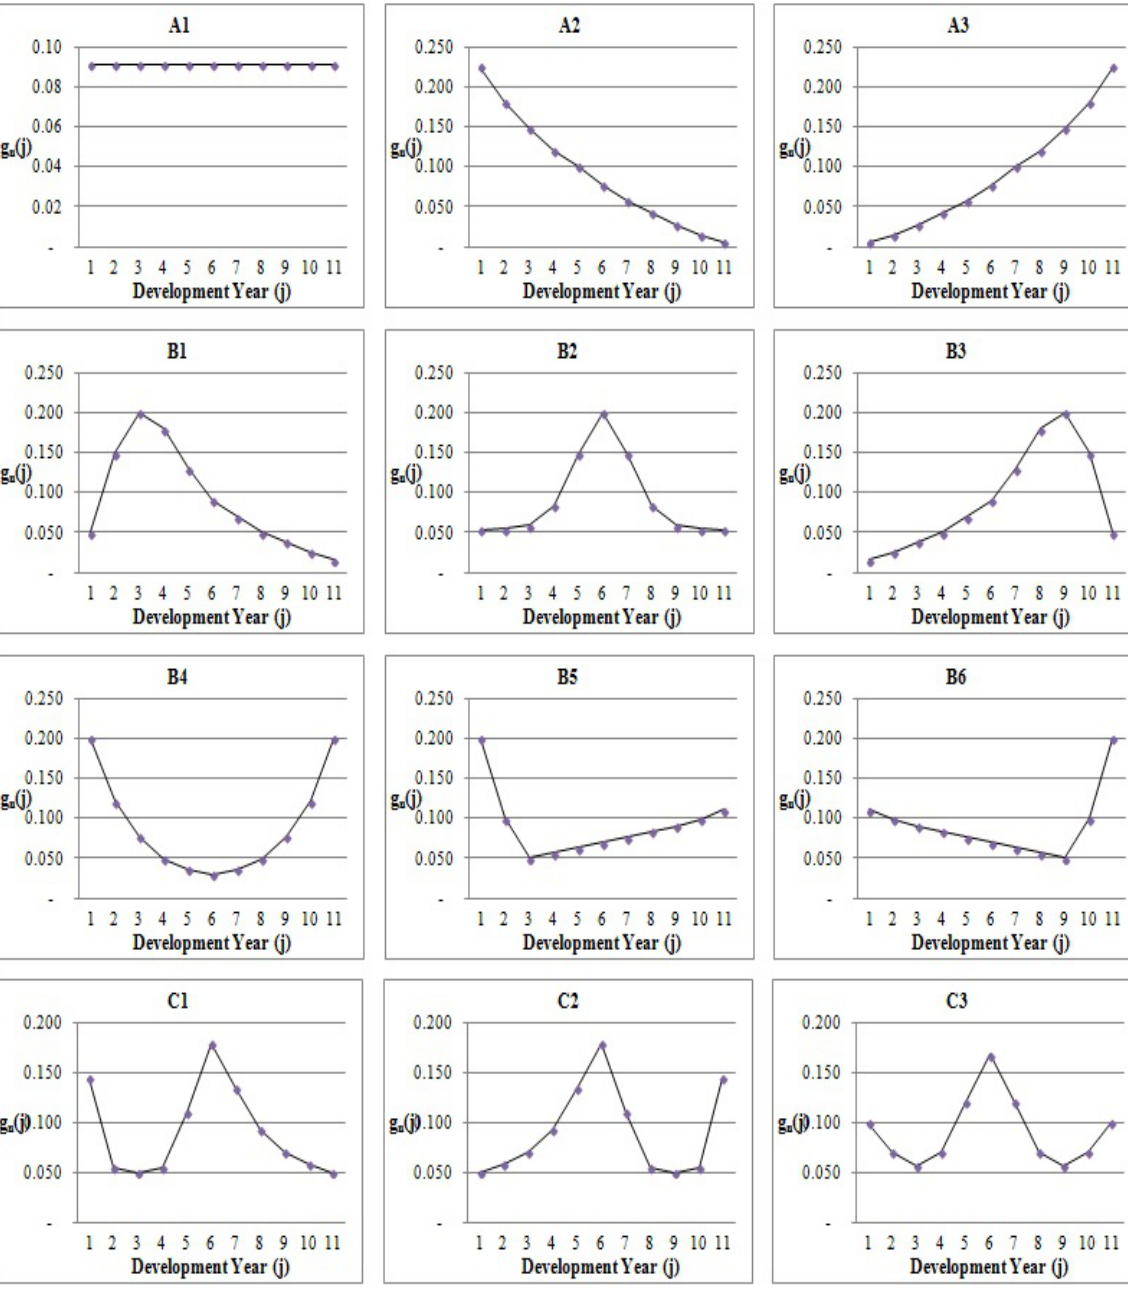
Fig. 1. Scenarios of the temporal distribution of